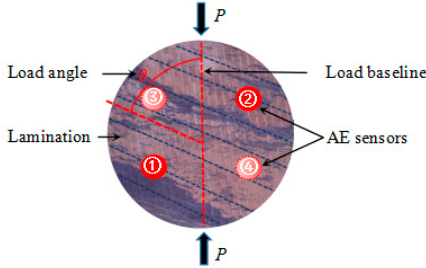
Figure 3. Schematic diagram of lamination angle loading and AE sensors’ layout.